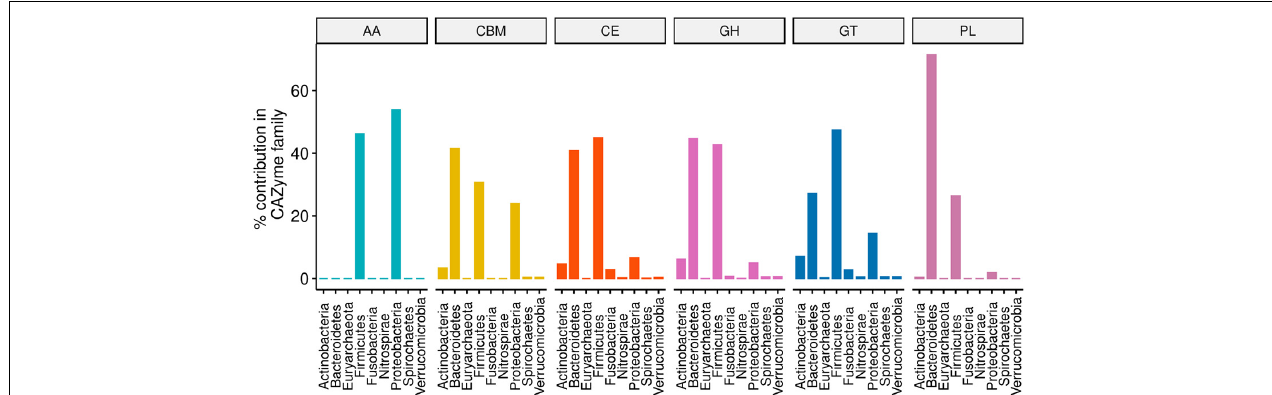
FIGURE 1 | Phylum-level percentage contribution to the abundance of each CAZyme family annotated from 310 type strain bacterial genomes. The proportions were computed on CAZyme family aggregates from a pool of 17406 gene copies obtained from 220 unique CAZyme families.